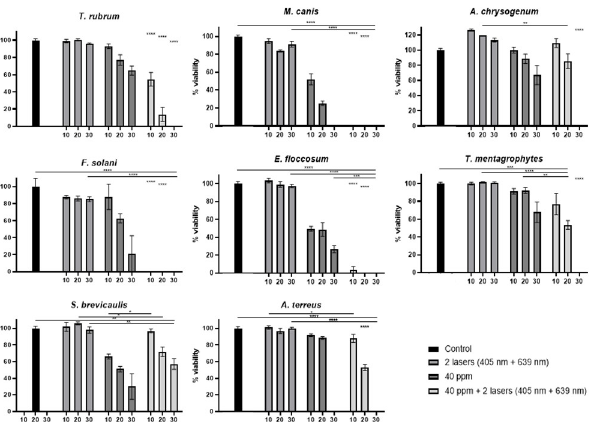
Fig 4. Percentage of viability for each of the eight fungal species with ozone treatment 40 ppm, in combination with both laser treatments simultaneously at three different times (10 min, 20 min and 30 min). Statistical significant results of the combined ozone and laser treatments are shown in comparison with only ozone, only laser treatments or absolute control at each time point, and indicated with asterisk. Asterisks without a comparison line indicate the same statistical significant results between all conditions at the same time.